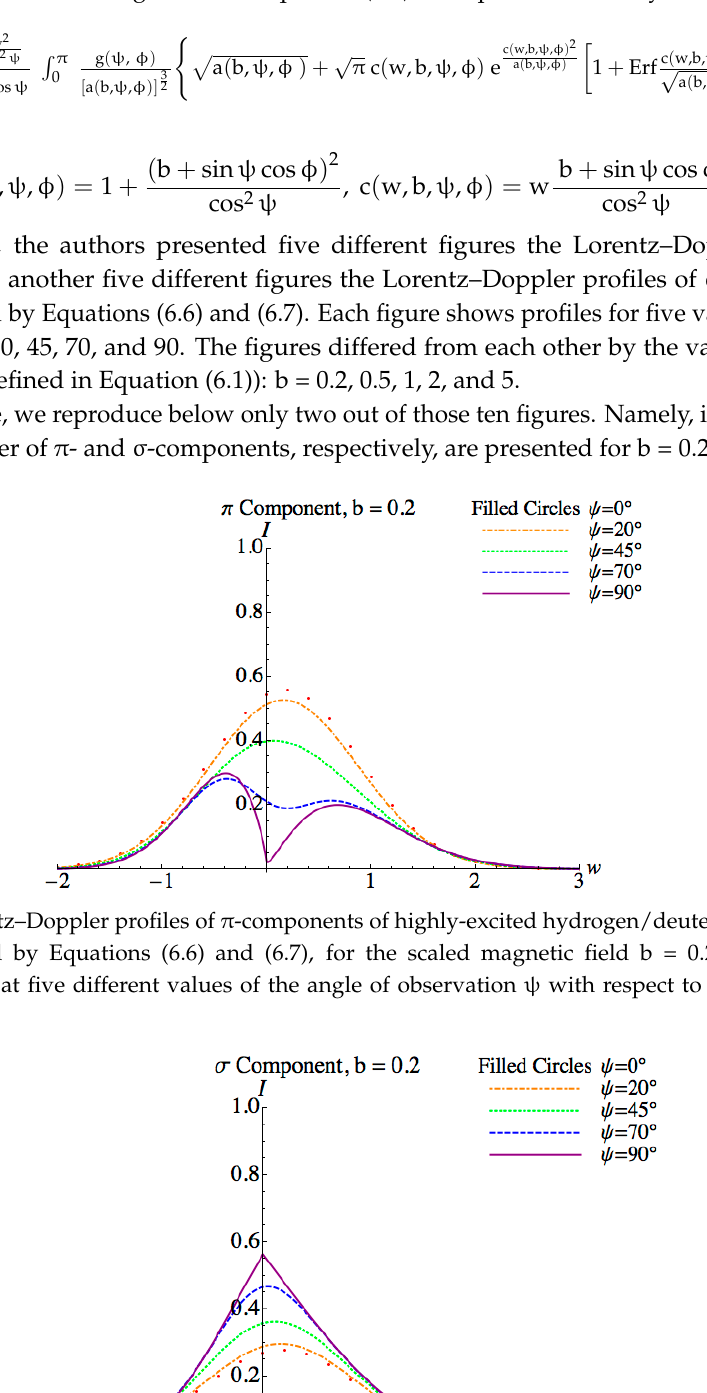
Figure 7. Lorentz–Doppler profiles of σ -components of highly-excited hydrogen/deuterium spectral lines calculated by Equations (6.6) and (6.7), for the scaled magnetic field b = 0.2 (defined in Equation (6.1)) at five different values of the angle of observation ψ with respect to the magnetic field [66].